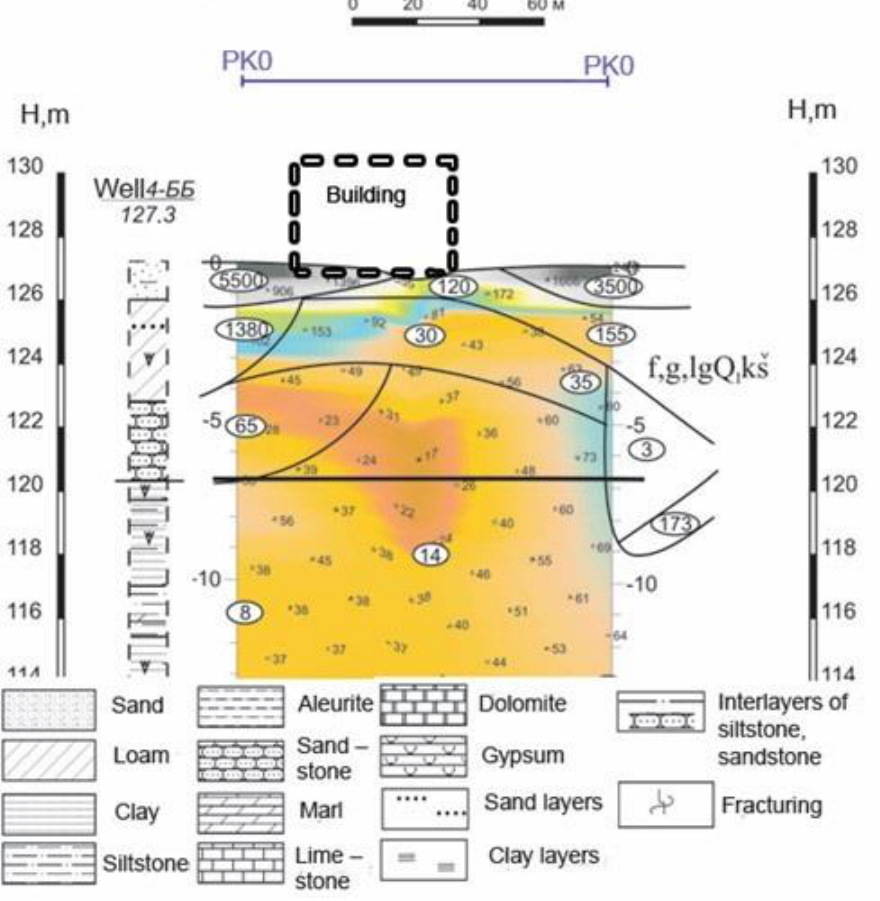
Figure 6. A ground cross section diagram. Table 2. The soil base